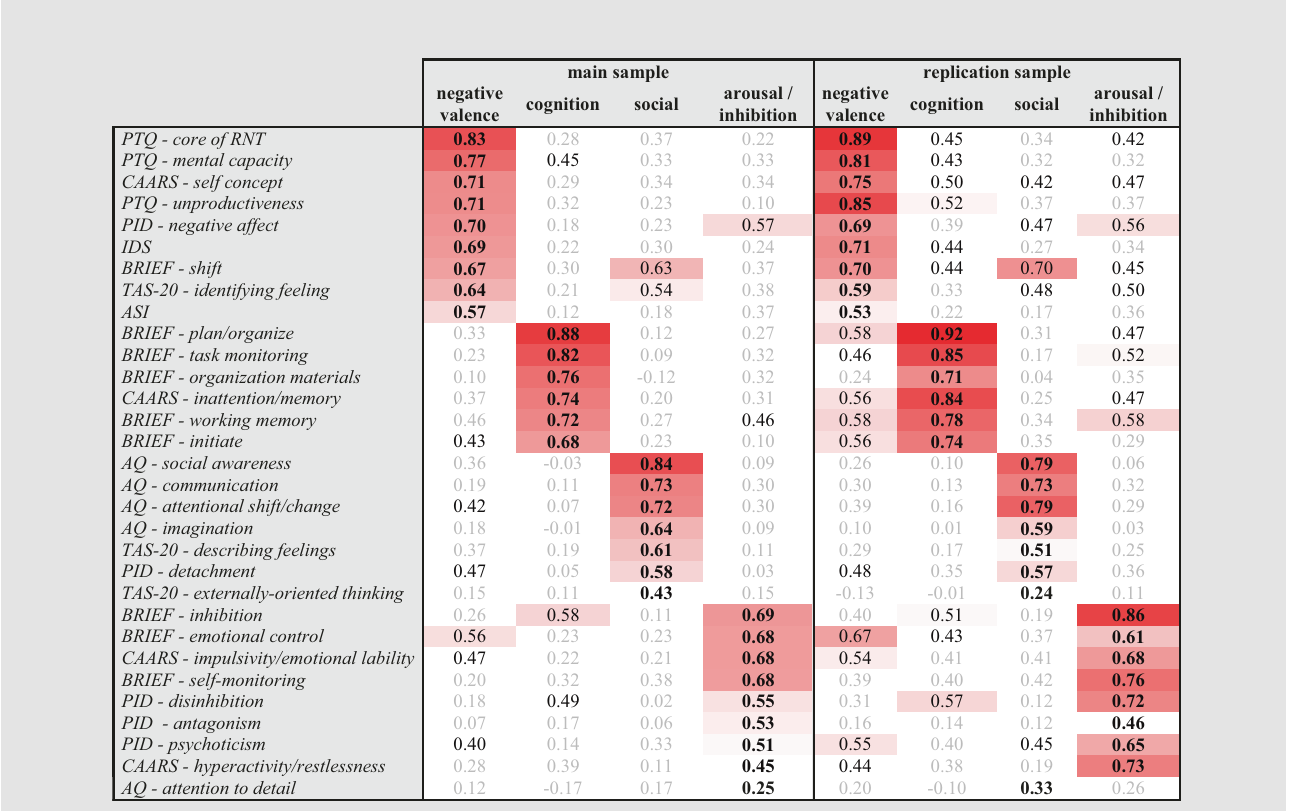
Table 2. Results of exploratory factor analysis and factor